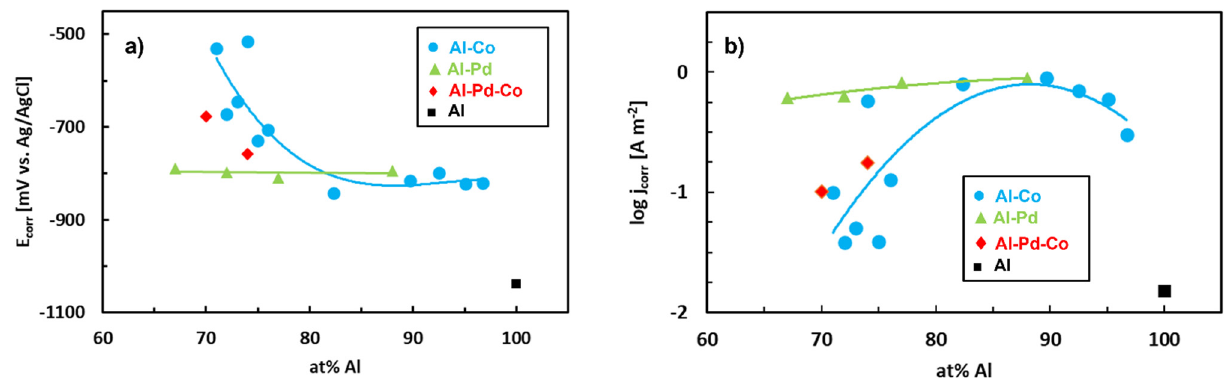
Figure 19. Corrosion parameters of Al–Pd, Al–Co and Al–Pd–Co alloys in aqueous NaCl (0.6 mol L − 1 ). Data is compiled from references [81,82,84,105,107].